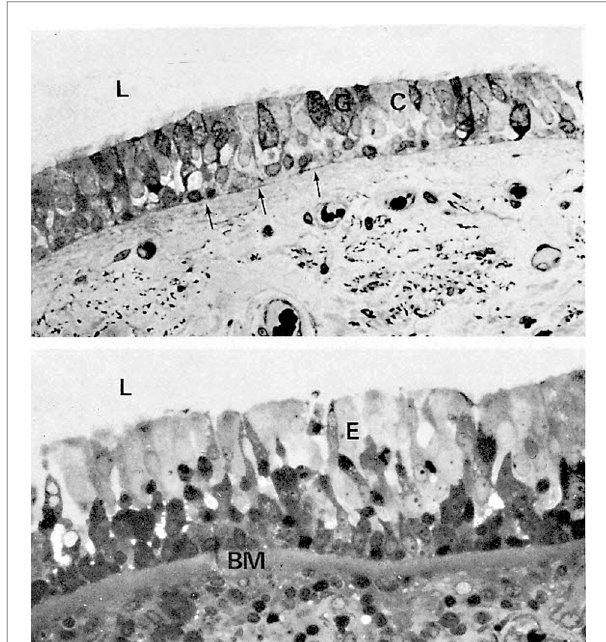
FIGURE 1 Upper light microscopical picture shows normal bronchial epithelium (L=lumen, C=ciliated cells, G=goblet cells). Thin arrows show the basement membrane (BM). Lower picture shows bronchial epithelium ( E ) from a patient with newly detected asthma. There Is edema fl uid between epithelial cells, BM Is swollen, and the tissue under BM (lamina propria) is full of eosinophils (black dots) (12, modi fi